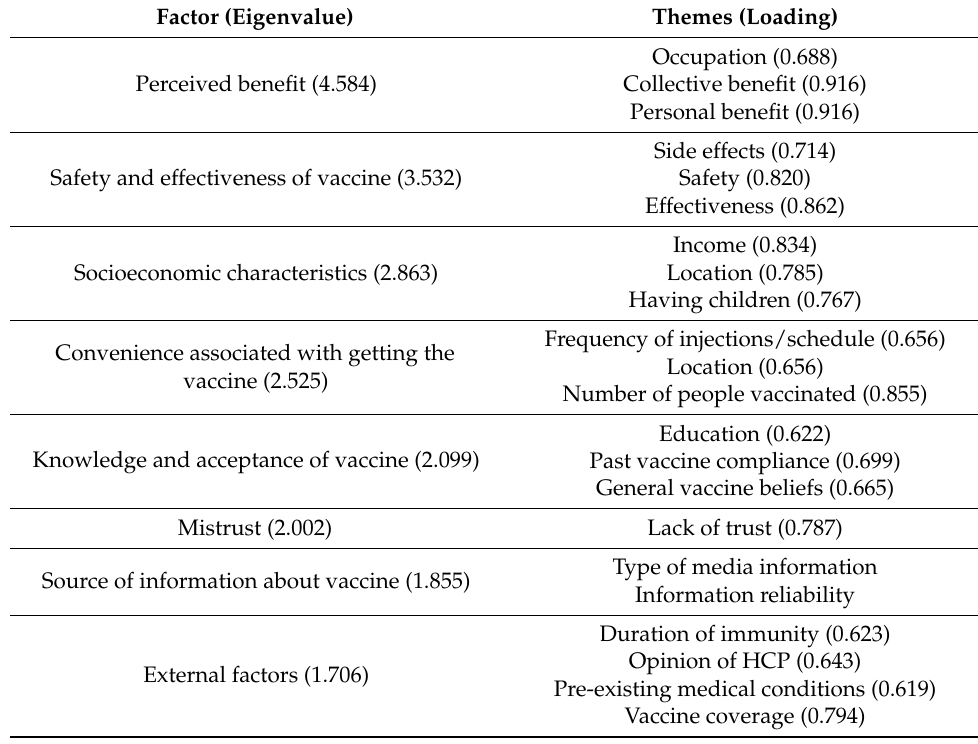
Table 4. Key factors, their underlying themes, and their associated loadings resulting from the PCA.